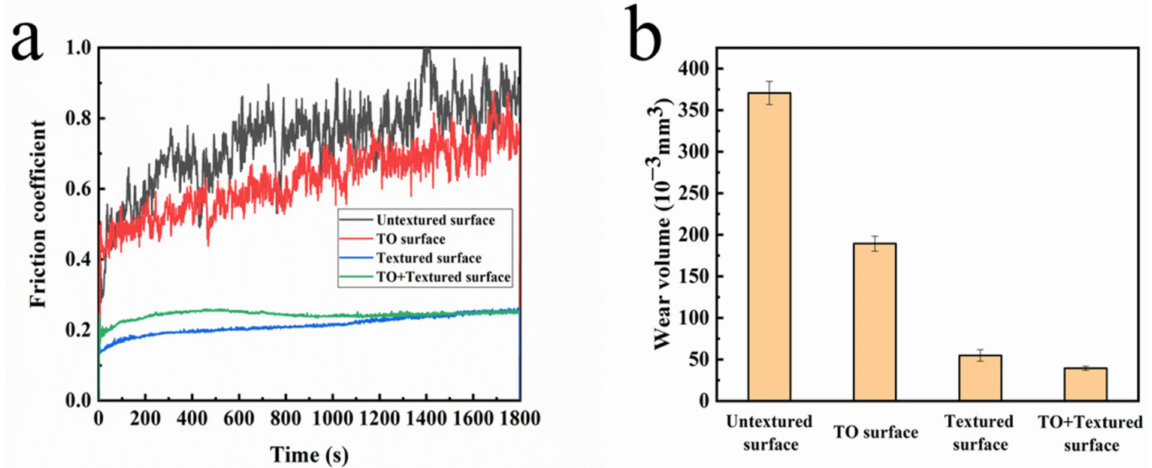
Figure 7. The variations of friction coefficient ( a ) and wear volume ( b ) of the different